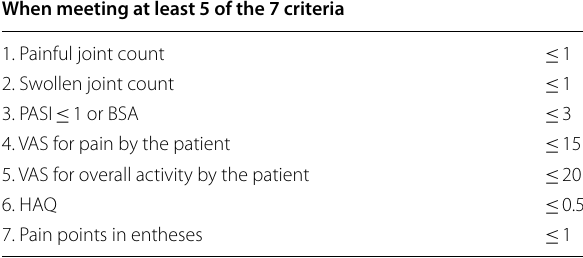
Table 2 MDA criteria for the evaluation of inflammatory disease activity [7,